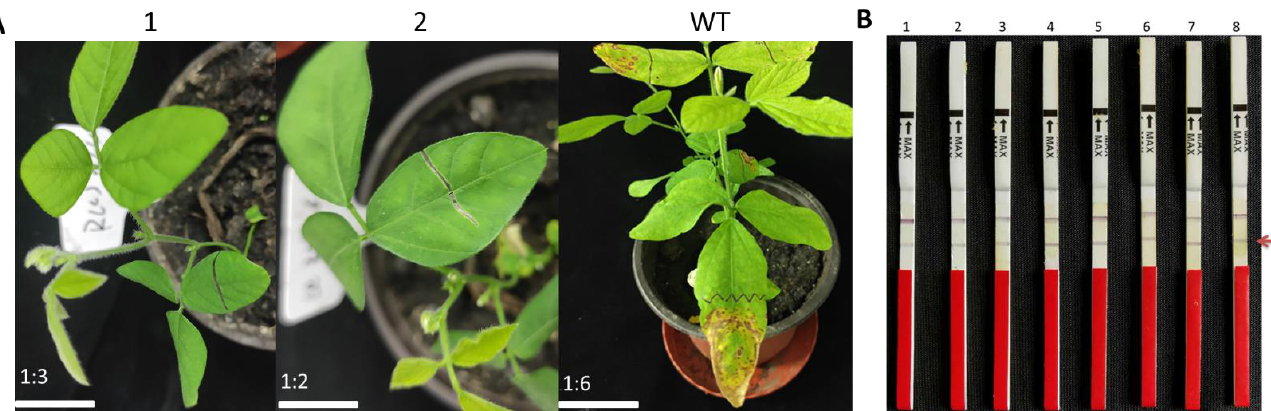
Figure A1. The identification of Basta resistance in transgenic plants. ( A ) Basta painting of T 0 generation transgenic plant in the greenhouse using a 1:1000 diluted solution of the herbicide Basta (135 g L − 1 ). ( B ) LibertyLink strip analysis of T 0 generation transgenic plants; lanes 1 – 8 are transgenic plants.